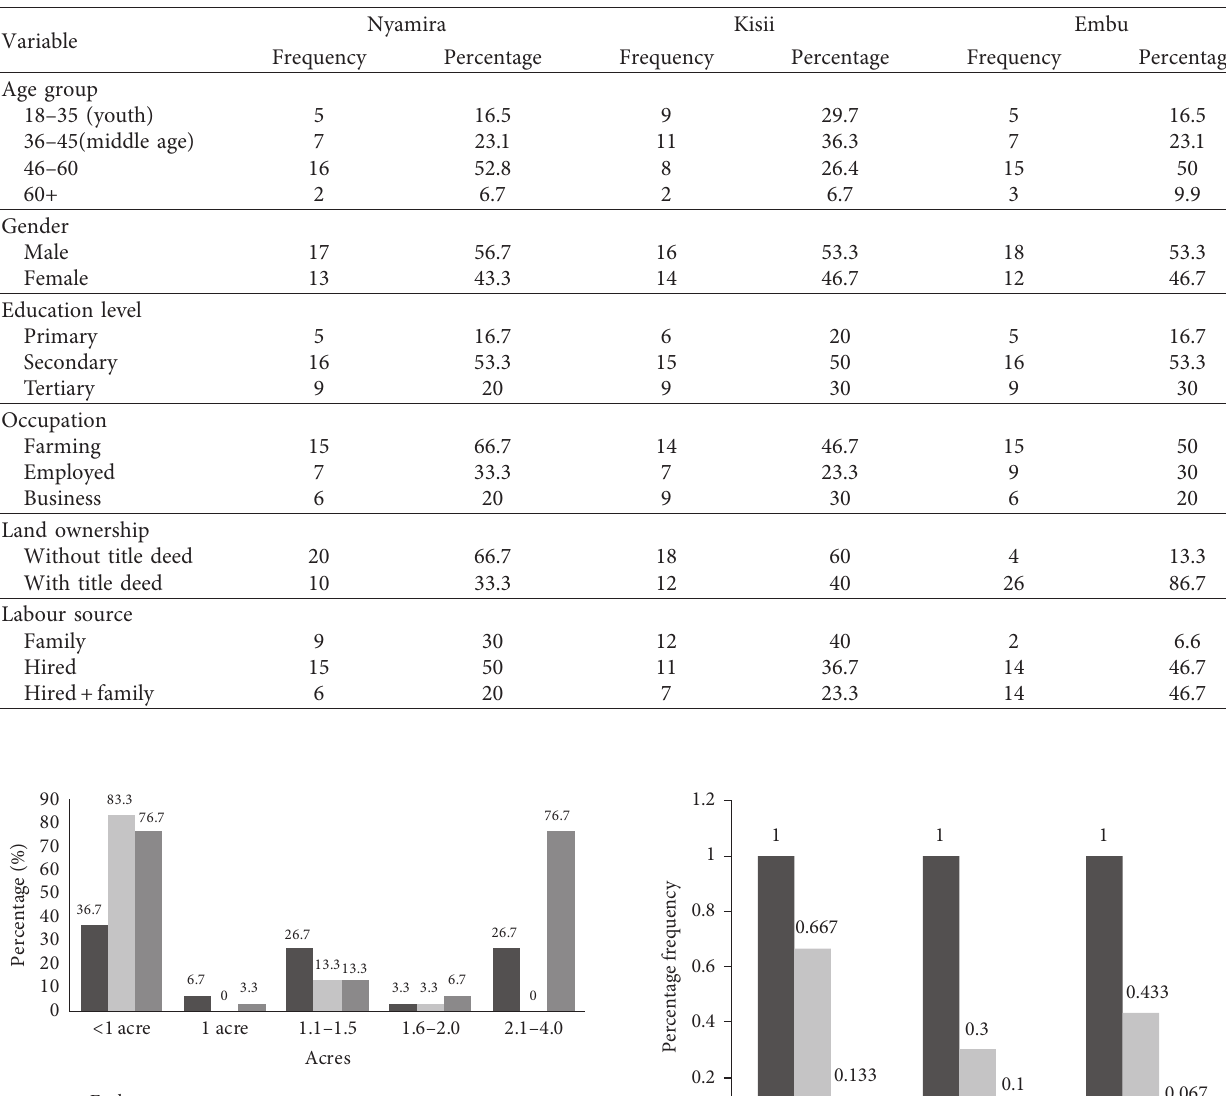
Table 1: Age distribution of respondents in Nyamira, Kisii, and Embu counties.